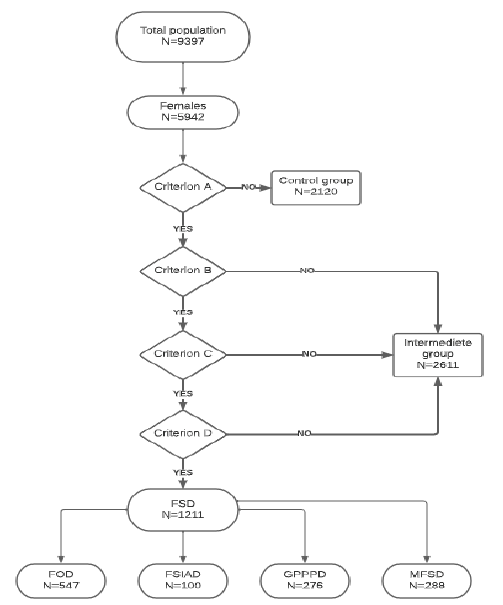
Figure 1. Transformation of DSM-5 criteria into online questions. The DSM-5 identifies three female sexual disorders (FOD, FSIAD, GPPPD) within sexual dysfunctions. The DSM-5 is structured by dividing each criterion into different subsections: Criterion A is the presence of the symptom. Criterion